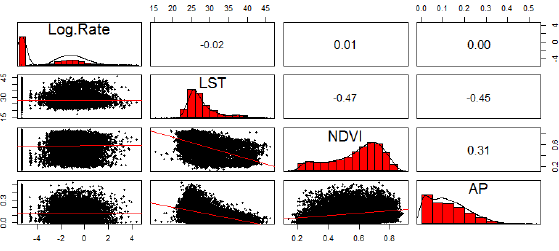
Figure 3: Correlation matrix of outcome and predictors. The mixed effects models had 41% explained variance overall. Stratification by LKN region brought the R 2 as high as 50% for major zones and as high as 59% for minor zones. Trend and seasonal oscillations contributes a major portion of the variability explained (see Figure 4; 37%). In terms of environmental predictor variables, LST and AP showed no significant risk association with disease rates. NDVI showed increased relative risk values in major zone 3 and minor zone 7 (RR = 1.64; CI95%: 1.01,2.67 and RR = 6.76 CI95%: 1.93,23.62, respectively). AP showed increased relative risk overall (RR = 1.47; CI95%: 1.01,2.15).